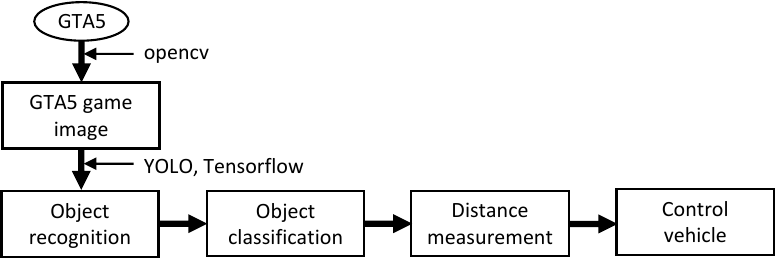
Figure 3. Object detection algorithm.